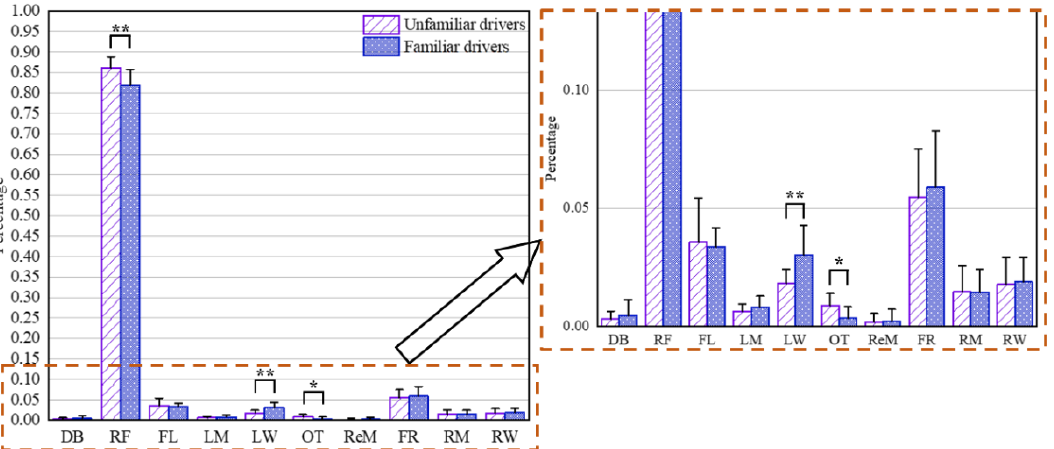
Figure 5. Percentages of total duration of fixations at each AOI at urban intersections for unfamiliar drivers and familiar drivers. The error bar denotes standard deviation. * denotes significance at the 0.05 level ( p ≤ 0.05). ** denotes significance at the 0.01 level ( p ≤ 0.01). RF refers to right front, FL refers to front-left, FR refers to front-right, LW refers to left window, LM refers to left mirror, RW refers to right window, RM refers to right mirror, ReM refers to rearview mirror, DB refers to dashboard and OT refers to others.